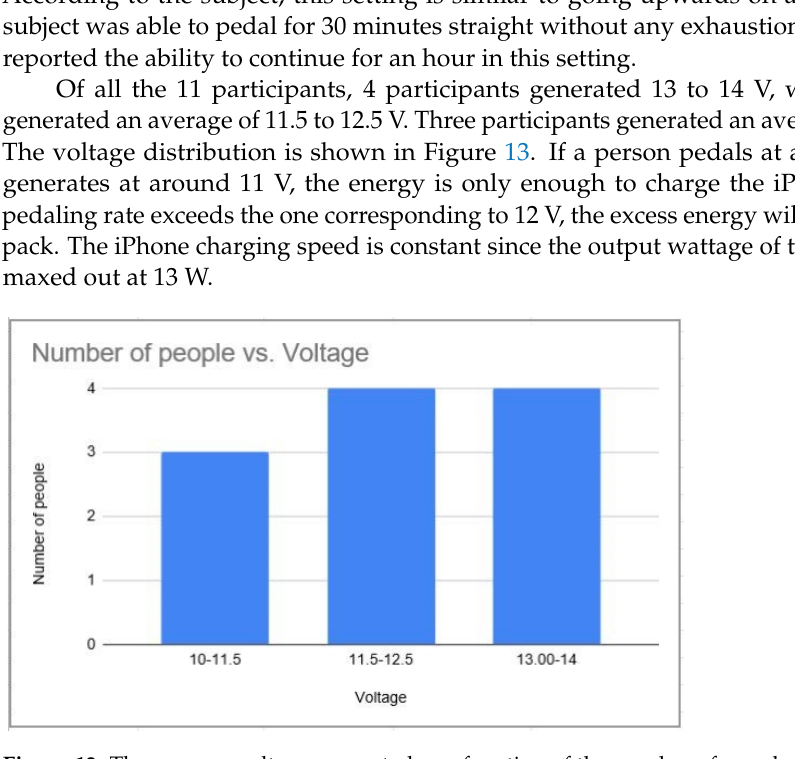
Figure 13. The average voltage generated as a function of the number of people using the device.